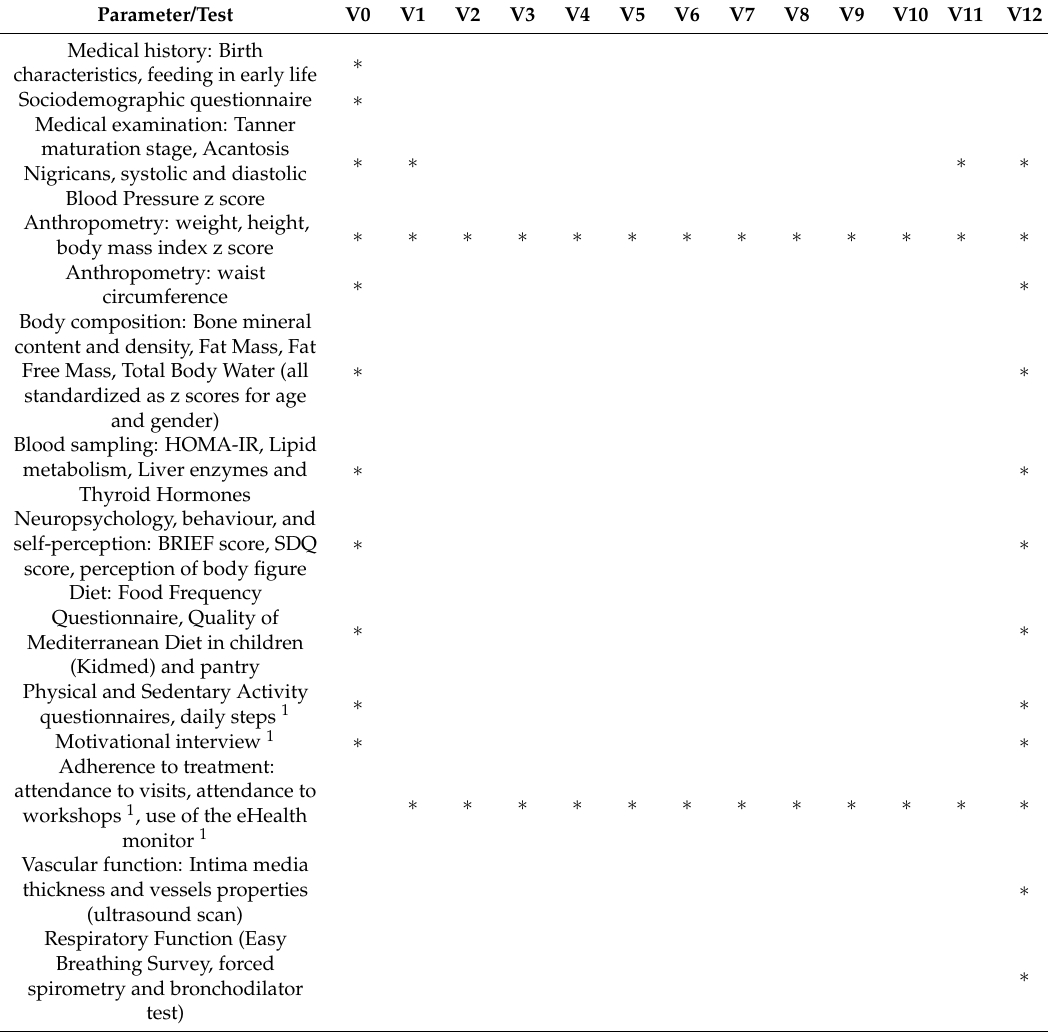
Table 2. Scheme of data collection per